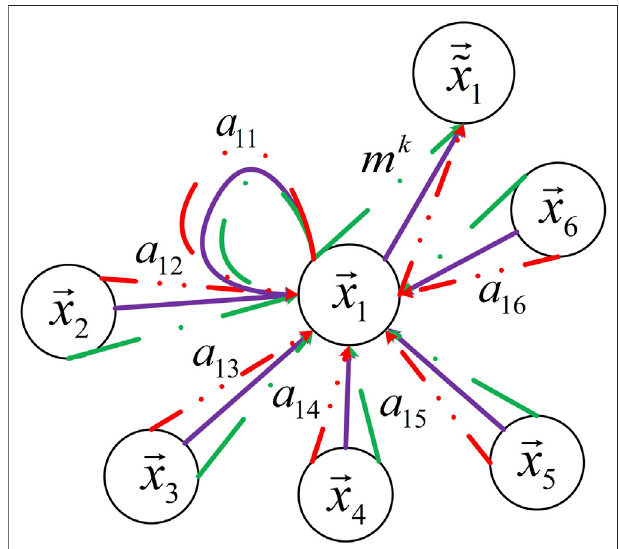
FIGURE 2 | Characteristic extraction